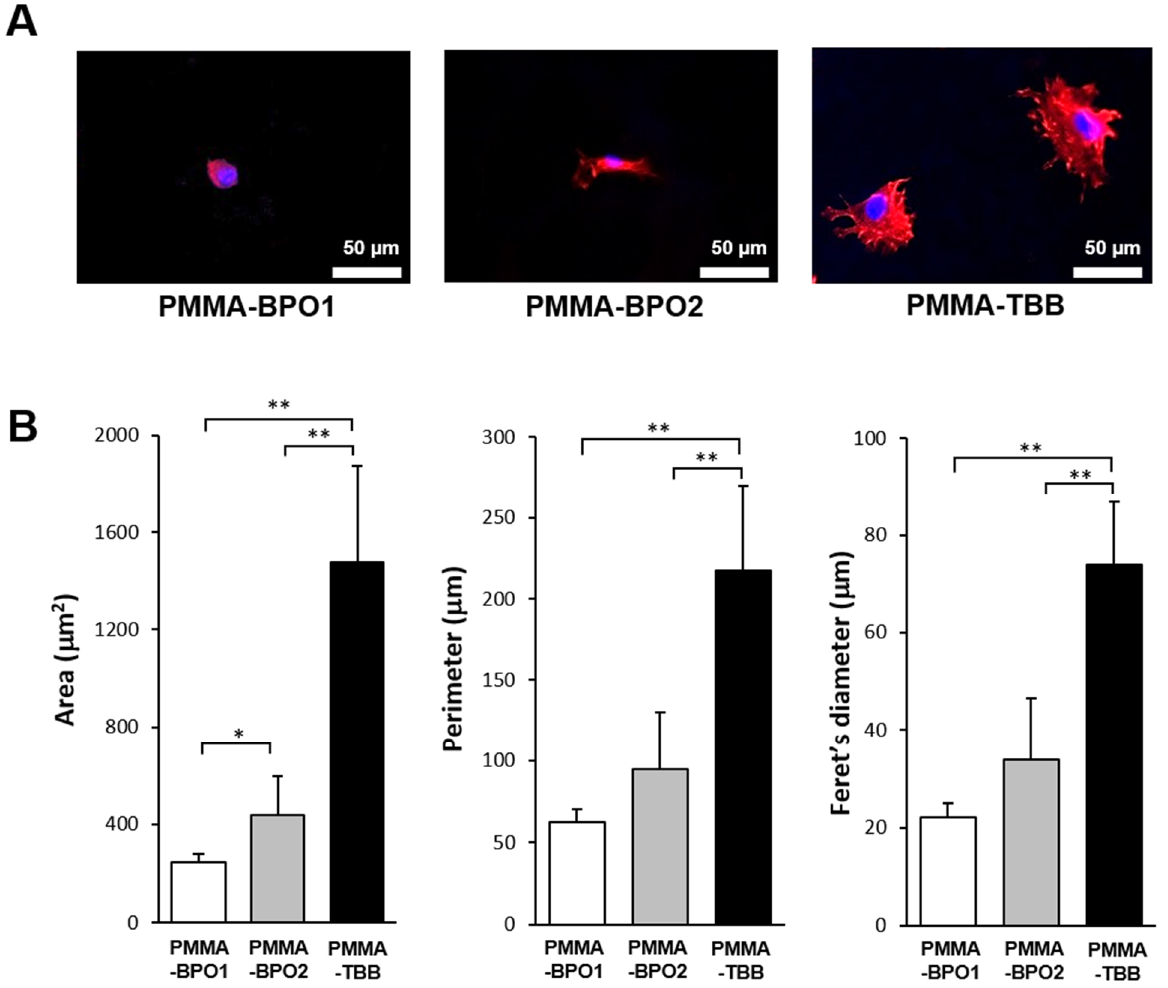
Figure 2. Osteoblastic behavior on bone cement materials. Cytomorphology and cytomorphometry were performed on seven-day-old bone cement specimens. ( A ) Fluorescence microscopy images of osteoblasts on day two of culture following immunochemical staining for cytoskeletal actin (red) and nuclei (blue). Scale bar = 50 µm. ( B ) Histograms for cytomorphometric parameters measured from the images. Each value represents the mean ± SD ( n = 6). Statistical differences between the three groups are shown (one-way ANOVA followed by Bonferroni test, * p < 0.05, ** p < 0.01).